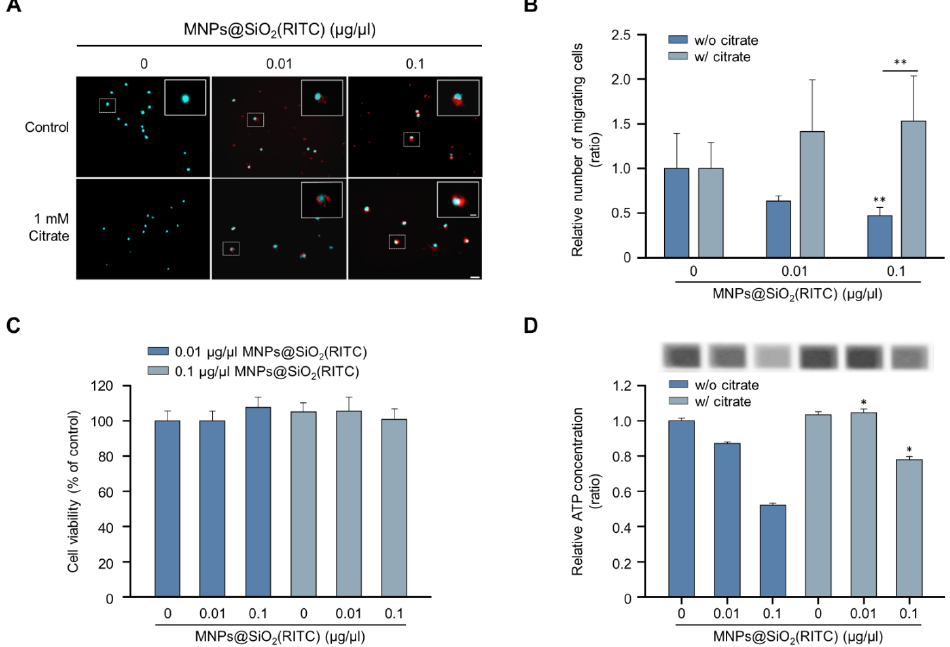
Figure 6. Recovered migratory activity of MNPs@SiO 2 (RITC)-treated BV2 cells by citrate treatment. ( A ) Transwell assay of MNPs@SiO 2 (RITC) and citrate co-treated BV2 cells. The nuclei of the cells were stained using Hoechst 33342, and the fluorescence was expressed as cyan. Fluorescence of MNPs@SiO 2 (RITC) distribution was expressed as red. The cells were counted under a fluorescence microscope in five randomly selected fields. The number of nuclei was counted in five randomly selected fields. Scale bar = 50 µ m. Scale bar of cropped image = 10 µ m. ( B ) The number of migrated cells. Data represent means ± standard deviation of three independent experiments. * p < 0.05 vs. control. ** p < 0.01 vs. control. ( C ) Viability of MNPs@SiO 2 (RITC)-treated BV2 cells in the presence of 1 mM citrate for 12 h. ( D ) Intracellular ATP levels in MNPs@SiO 2 (RITC)-treated BV2 in the presence of 1 mM citrate for 12 h. Data represent means ± standard deviation of three independent experiments. * p < 0.05 vs.